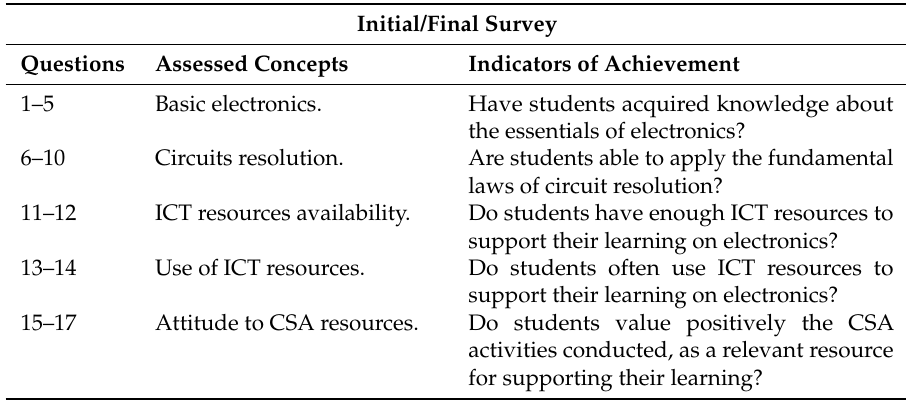
Table 3. Description of the content in the survey.